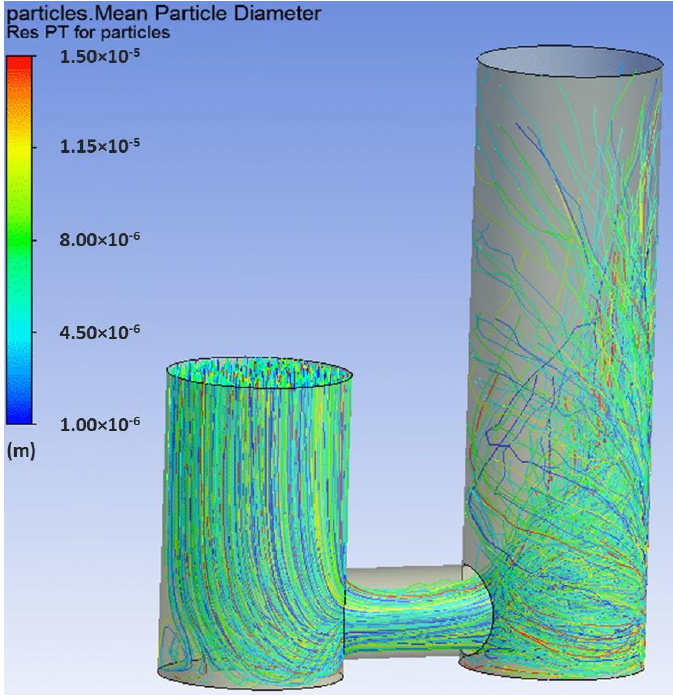
Figure 6. Predicted particle tracks from ANSYS Fluent that stick to side walls in the case 2 simulation.